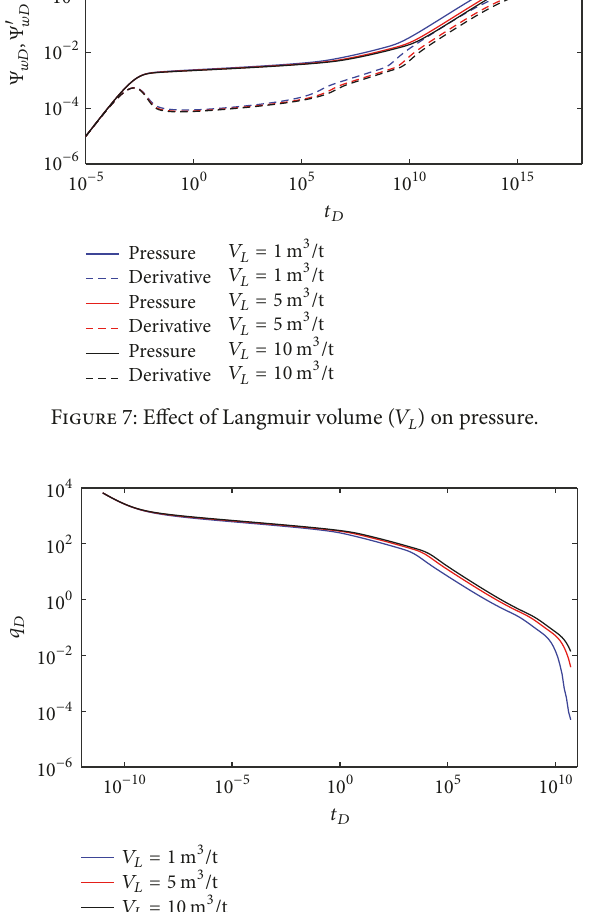
Figure 6: Effect of hydraulic fracture permeability on production.